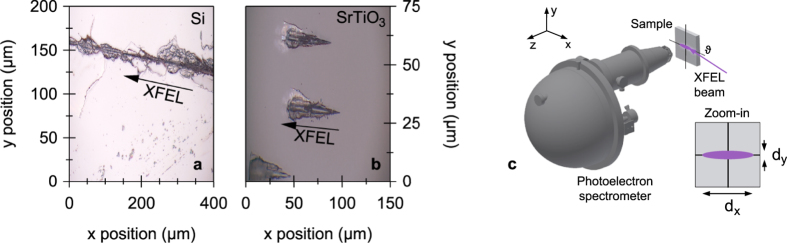
XFEL-induced sample ablation and experimental geometry.Radiation damages on the surfaces of Si (a) and La-doped SrTiO3 (b) when operating with a microfocused XFEL beam at a fluence, i.e., pulse energy per area, of 175 Jcm−2. The direction of photon incidence is indicated by arrows. (c) The angle of photon incidence ϑ (relative to the sample surface) can be varied by sample rotation, resulting in a changed spot diameter dx on the sample surface at a constant spot diameter dy. The axis of the entrance lens of the photoelectron spectrometer (z direction) was perpendicular to the direction of the photon beam (x direction) in all cases.